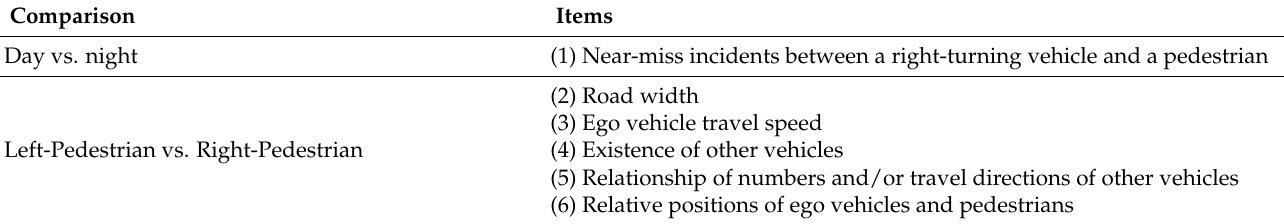
Table 1. Data analysis items. Comparison Items Day vs. night (1) Near-miss incidents between a right-turning vehicle and a pedestrian